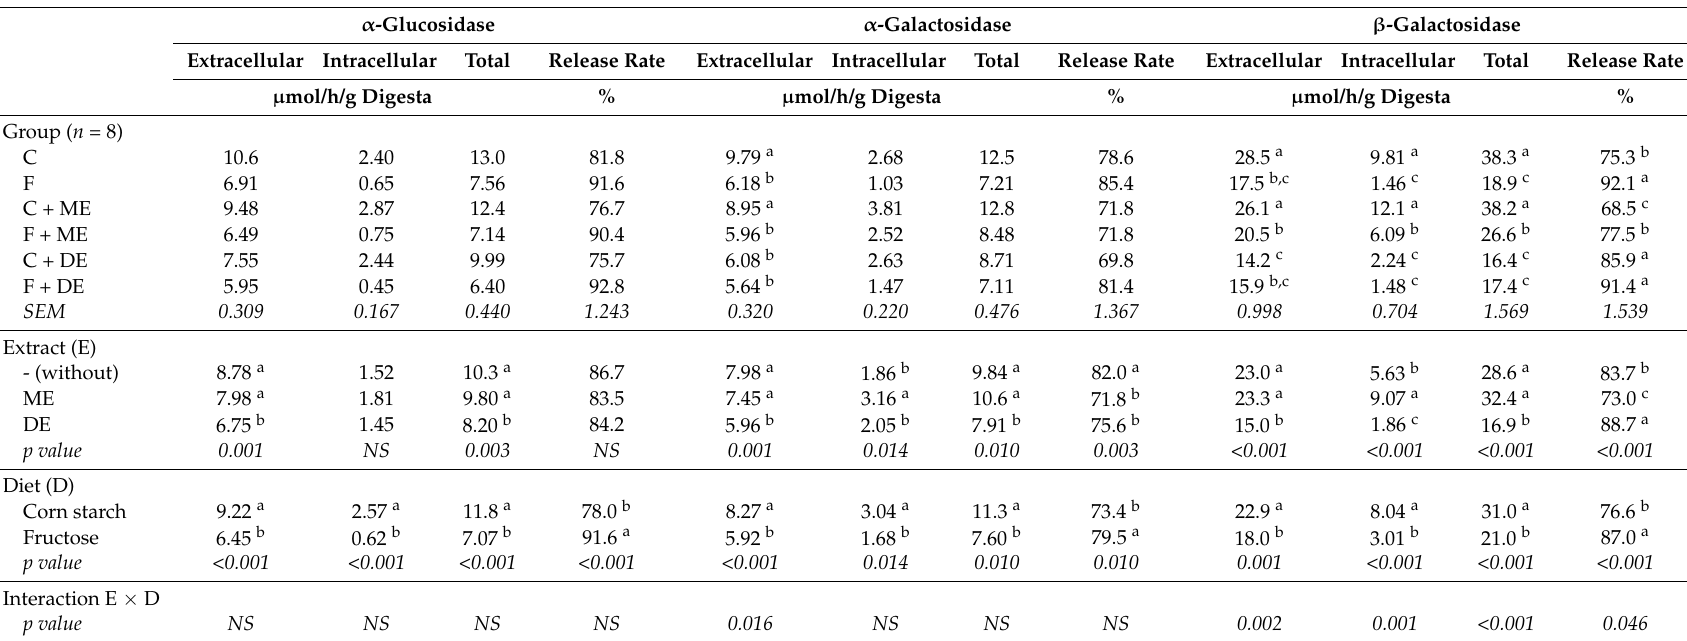
Table 3. Cecal bacterial enzyme activity and their release rate into the intestinal environment in rats